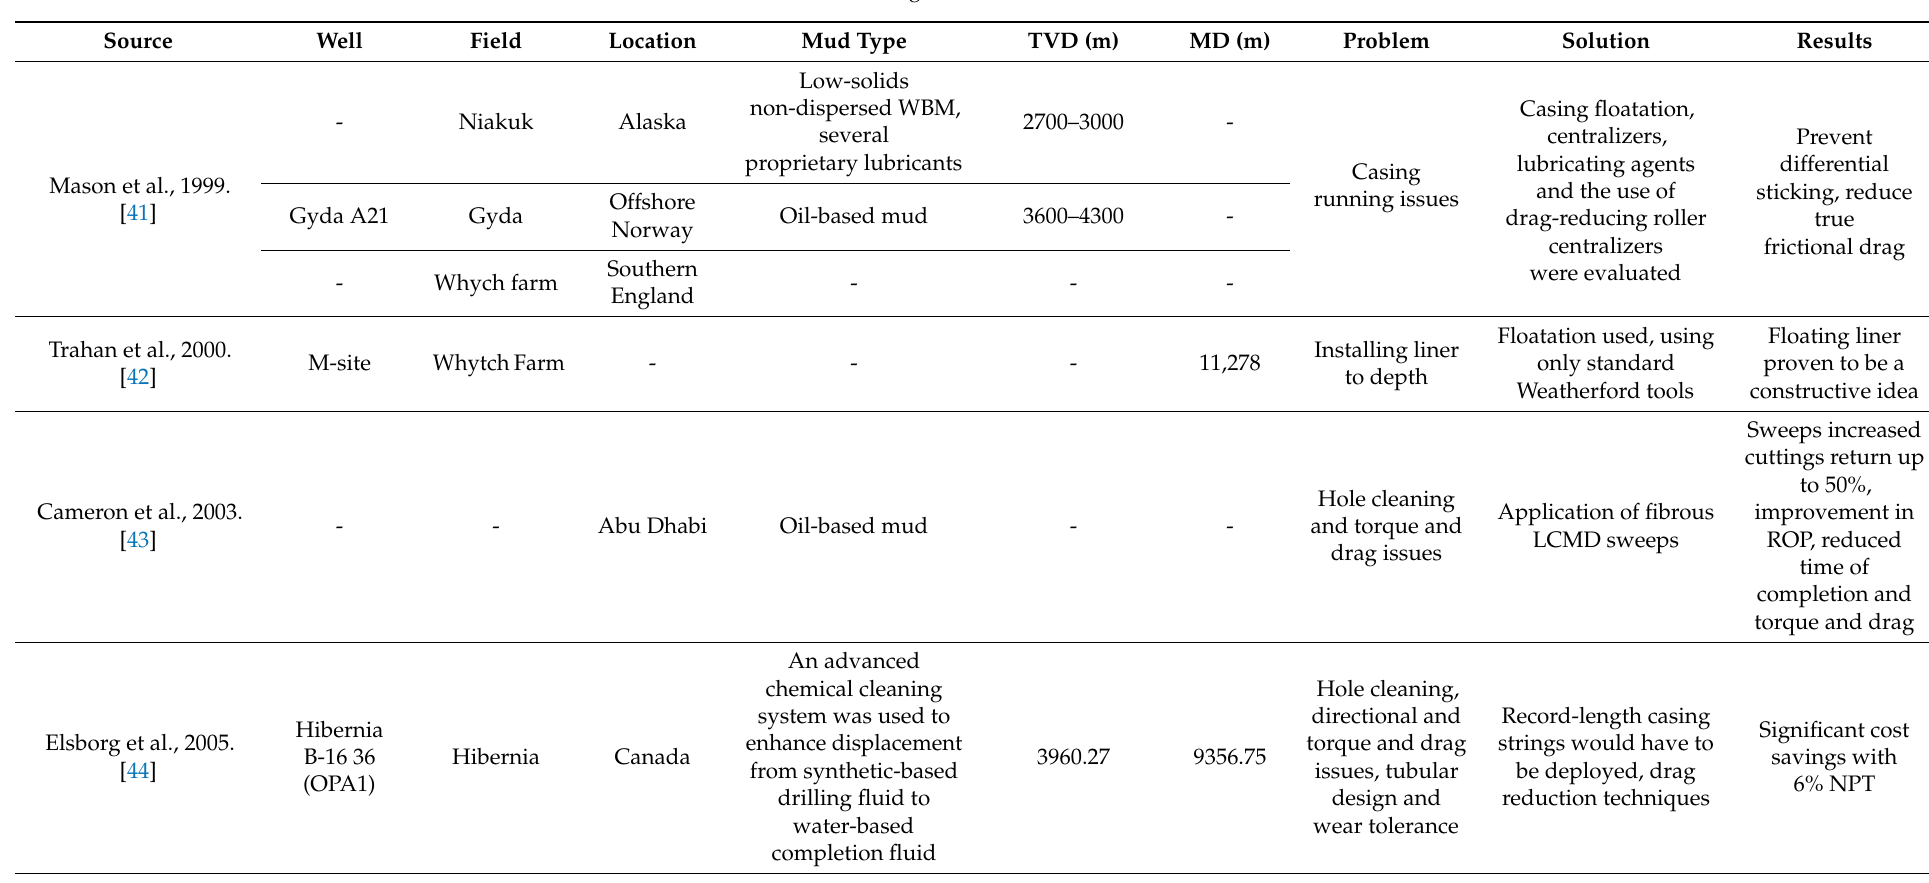
Table 1. Problems and solutions in extended-reach